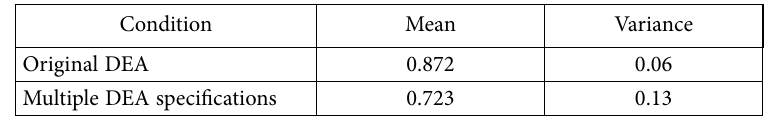
Table 6. The compared results